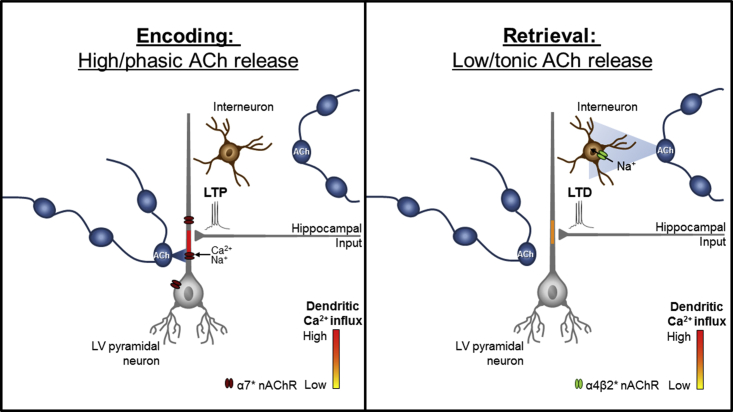
Nicotinic Modulation of Layer V Pyramidal Neurons during Encoding and Retrieval of Associative Recognition MemorySchematic representation of nAChR subtype-specific regulation of HPC-mPFC transmission during memory encoding (left) and retrieval (right) resulting from differential modes or concentrations of ACh release. During encoding, ACh is released in a phasic manner, giving rise to high concentrations that activate α7 nAChRs on pyramidal cells. This coupled with presynaptic HPC activity and pyramidal cell firing results in sufficient postsynaptic calcium to trigger LTP at the HPC-mPFC synapse. During retrieval, ACh is released in a diffuse manner giving rise to low concentrations that activate α4β2 nAChRs on interneurons. The resultant GABAergic signaling attenuates an STDP-induced increase in postsynaptic calcium levels, leading to the triggering of LTD.